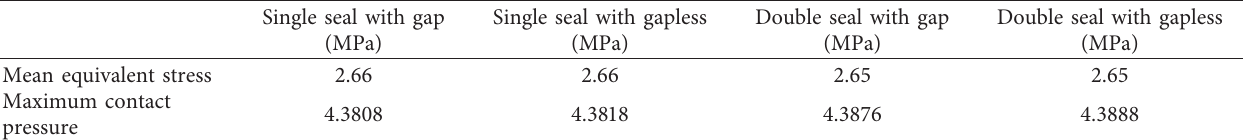
Table 1: Mean average pressure and maximum contact pressure for different sealing